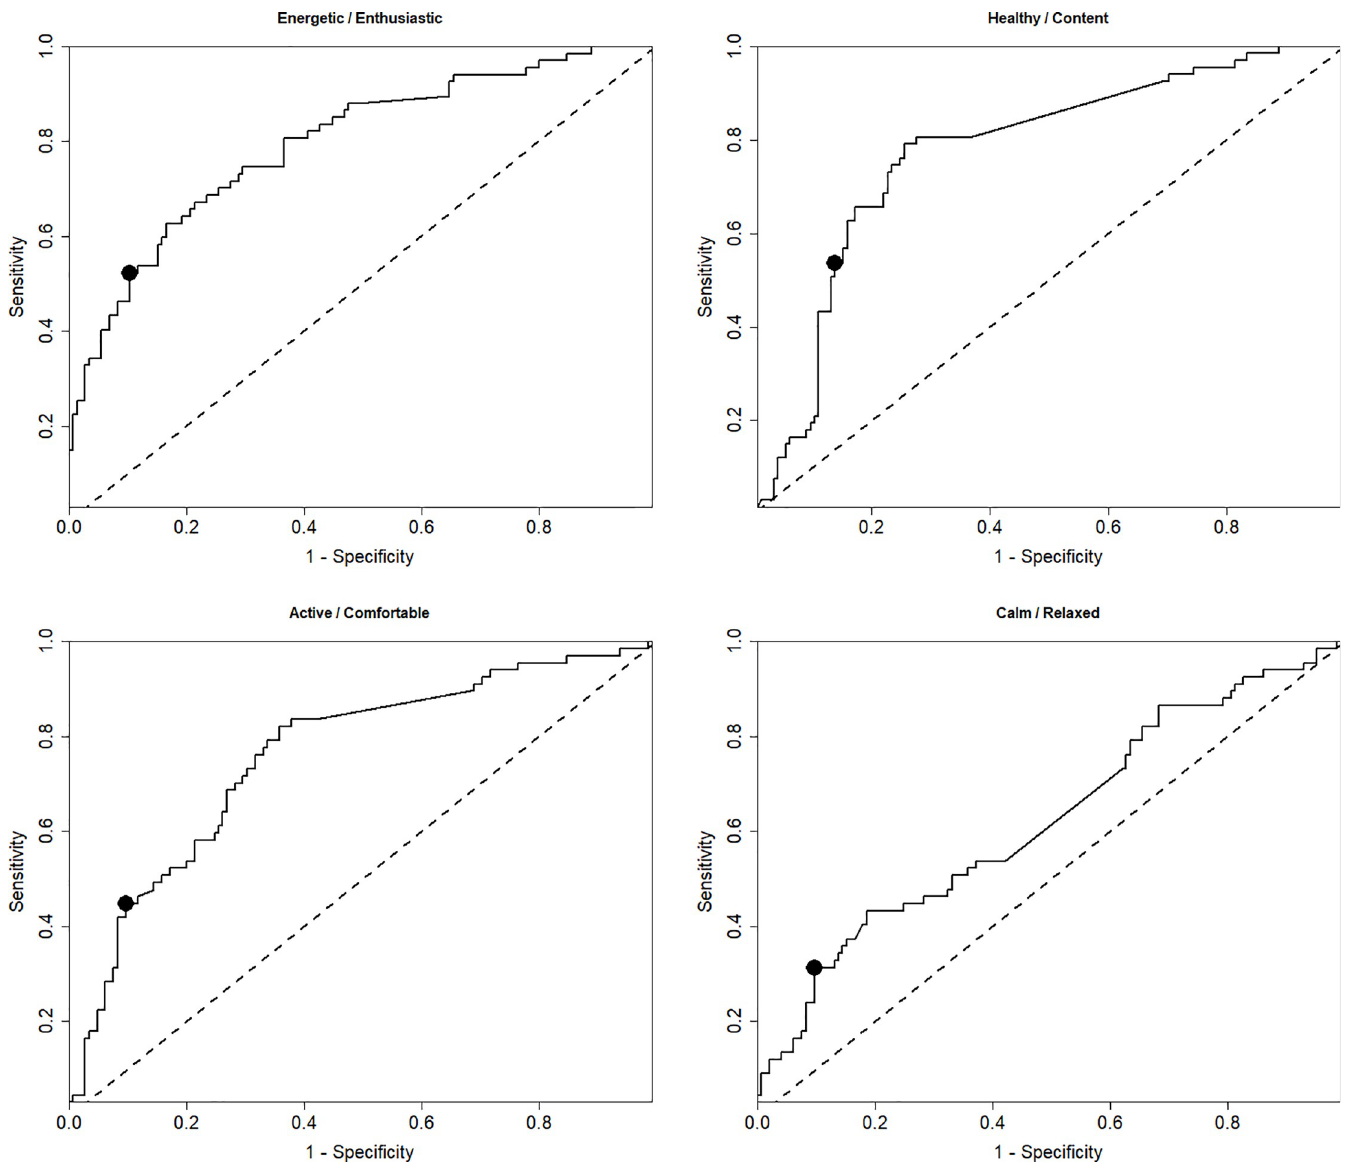
Fig 6. ROC curves show all possible MIDs with the corresponding sensitivities and 1 –specificities. ROC curves are shown for (A) Energetic / Enthusiastic, (B) Healthy / Content, (C) Active / Comfortable and (D) Calm / Relaxed. The MIDconsistent cut-off is plotted as a large point on each ROC